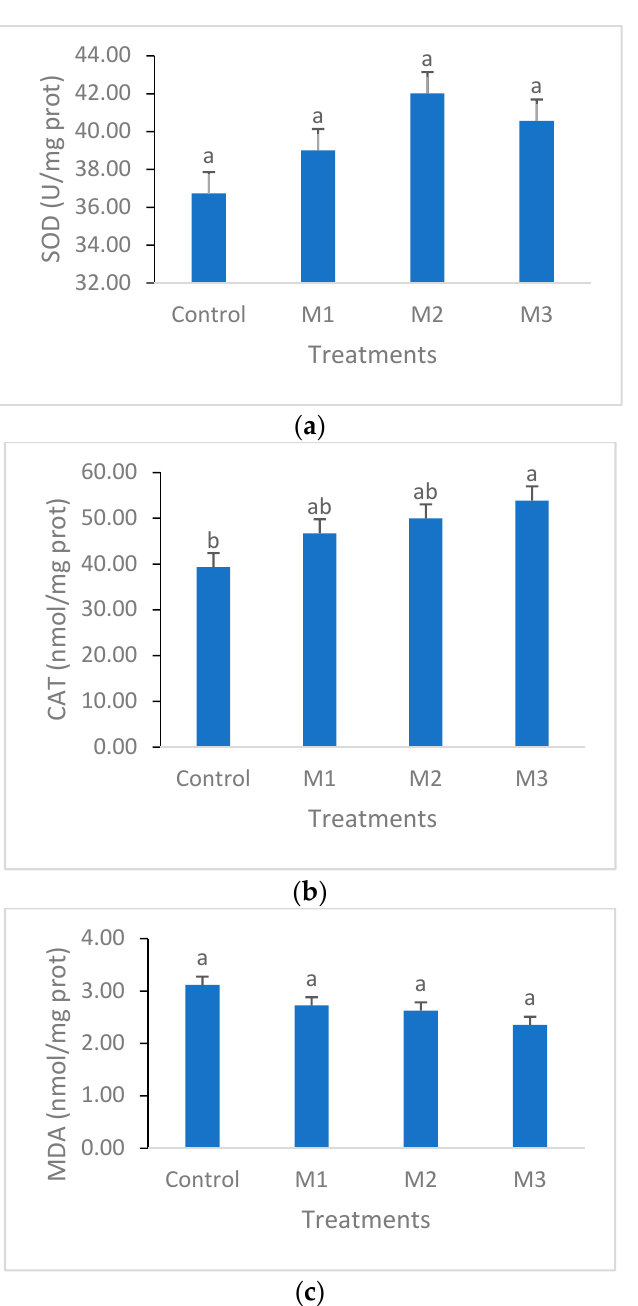
Figure 2. Oxidative stress parameters of SOD ( a ), CAT ( b ), and MDA ( c ) of C. carpio fed a basal diet incorporated with zero (control), 0.5% (M1), 1% (M2), and 2% (M3) of Myristica fragrans for four weeks. Values are presented as the mean ± SE. Different letters indicate significant differences ( p < 0.05).